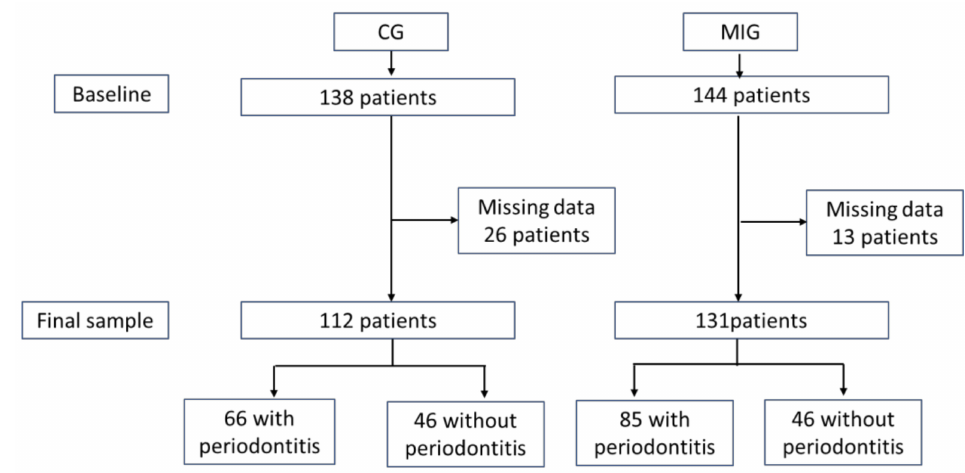
Figure 1. Study flow